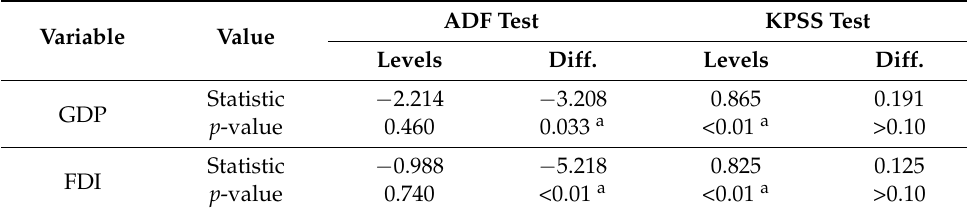
Table 4. Results of the stationarity test of the variables used in the